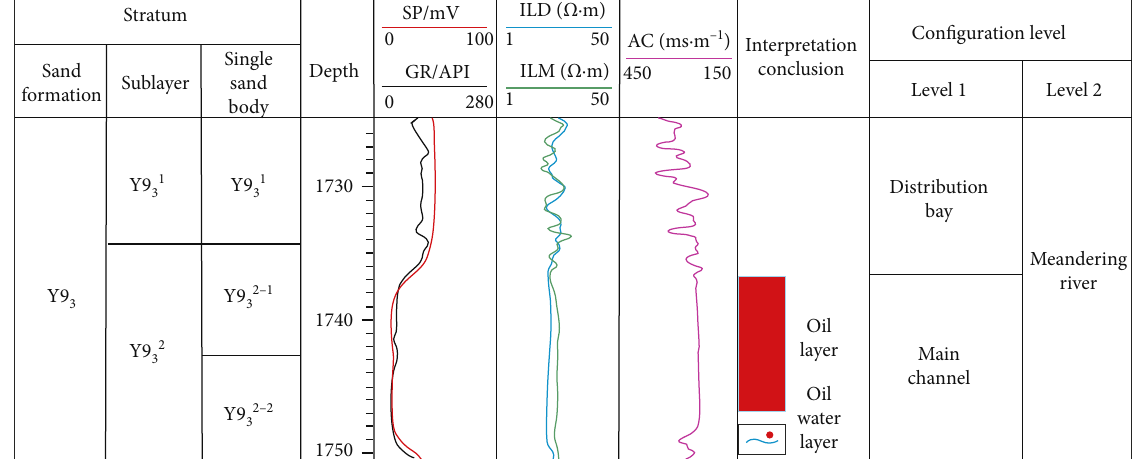
Figure 6: Well logging interpretation modes of reservoir con fi guration unit in the Yan 9 32 layer